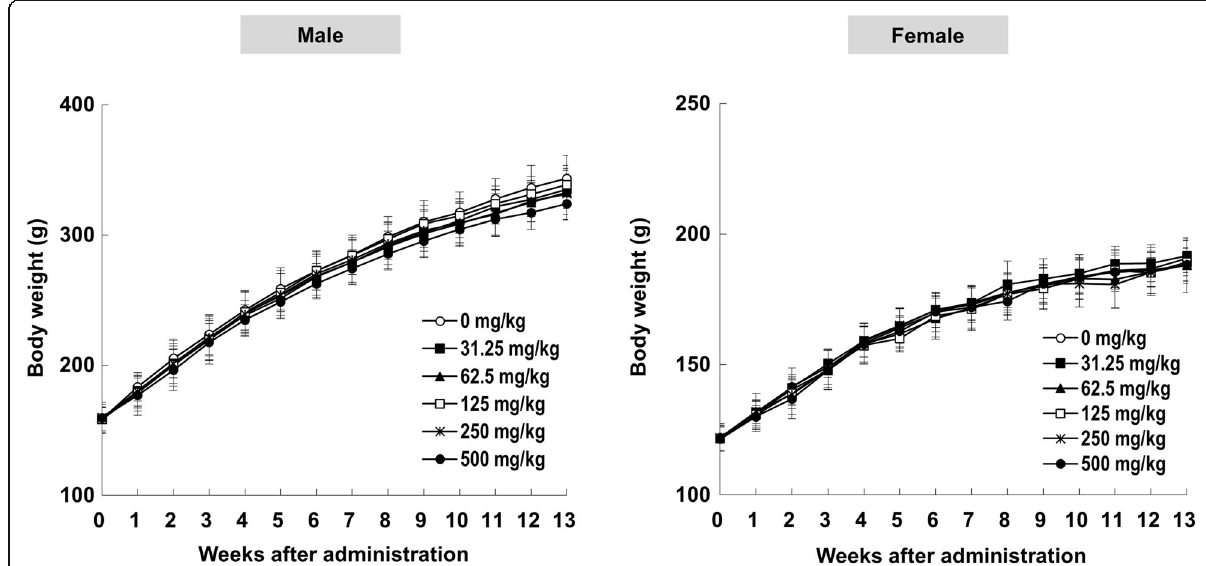
Fig. 3 Body weight values of male and female F344 rats orally administered with Tiglium seed extract in 13-week repeat-dose toxicity study. Data are expressed as means ± SD ( n = 9 –